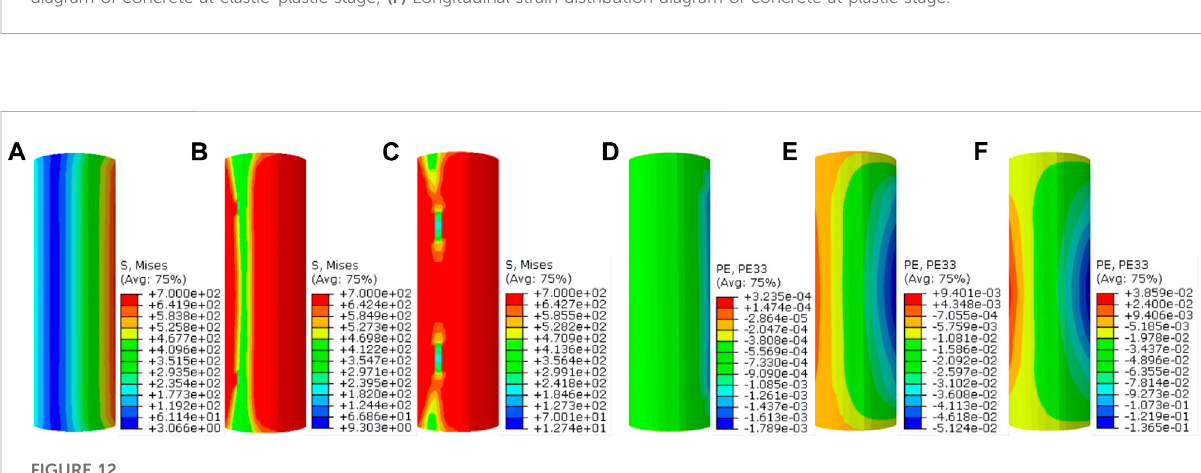
FIGURE 12 Distribution of MIES stresses and longitudinal strains of steel tubes at each loading stage of typical specimen HCHST-6: (A) The MISES stress distribution of steel tube at elastic stage; (B) The MISES stress distribution of steel tube at elastic-plastic stage; (C) The MISES stress distribution